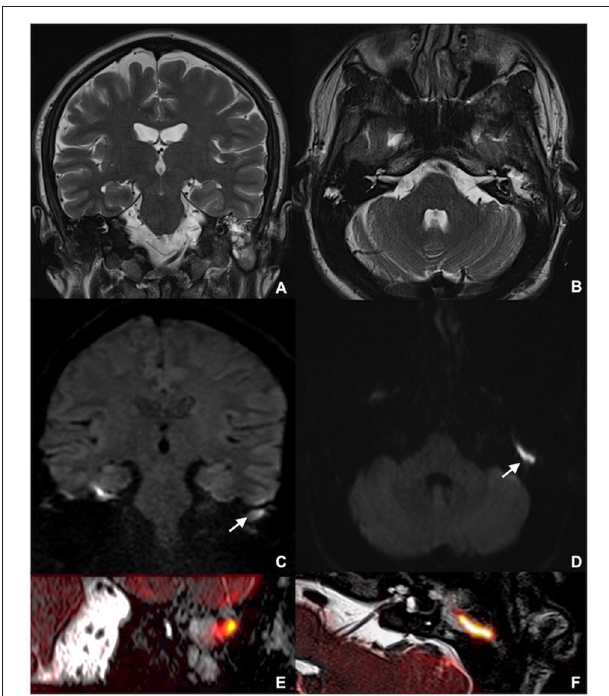
FIGURE 1 | MRI showing left middle ear recurrent cholesteatoma in a 26-year-old man: coronal (A) and axial (B) TSE T2w; coronal MSH non-EPI DWI (C) and axial SE-EPI DWI (D) ; detailed coronal (E) and axial (F) fusion imaging of both ultra-thin heavily-weighted 3D T2w sequences and DWI images. MRI, magnetic resonance imaging; TSE, turbo spin echo; MSH, multi-shot; EPI, echo planar imaging; DWI, diffusion weighted imaging; SE,